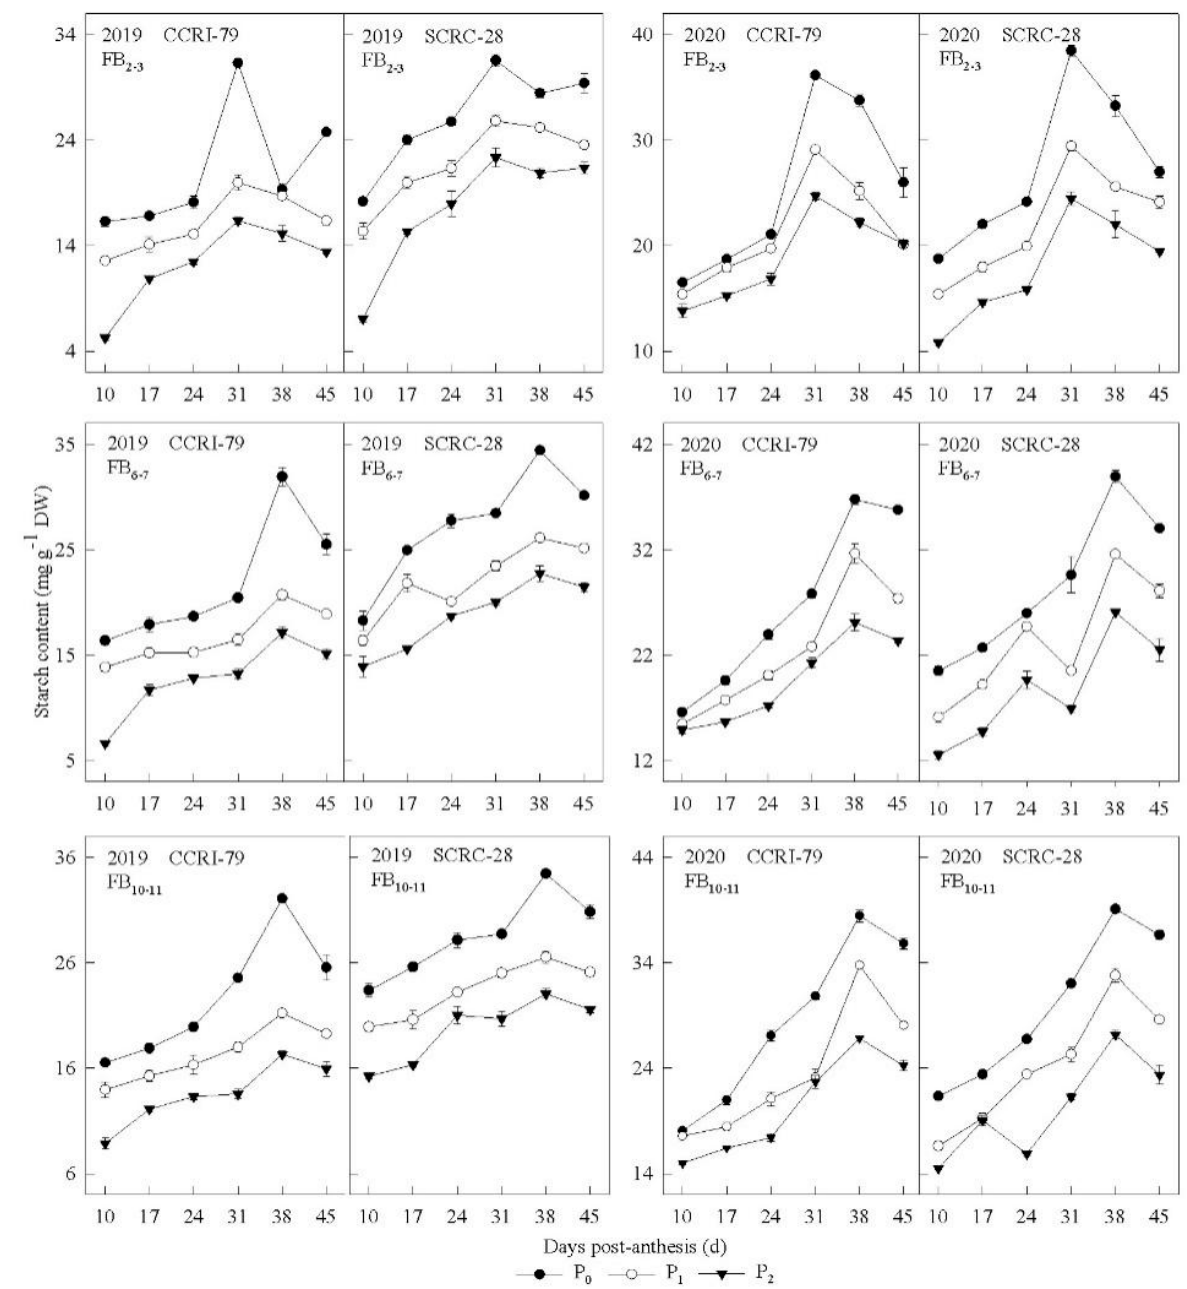
Figure 6. The effect of soil available phosphorus (AP) on the starch content of subtending leaves in 2019 and 2020 cotton ‐ growing seasons. d: day. FB: fruiting branch. P 0 : 3 ± 0.5 mg kg − 1 . P 1 : 6 ± 0.5 mg kg − 1 . P 2 : 15 ± 0.5 mg kg − 1 . Table 2. The effect of soil available phosphorus (AP) on the maximum and minimum sucrose contents and sucrose transformation rates of subtending leaves in 2019 and 2020.